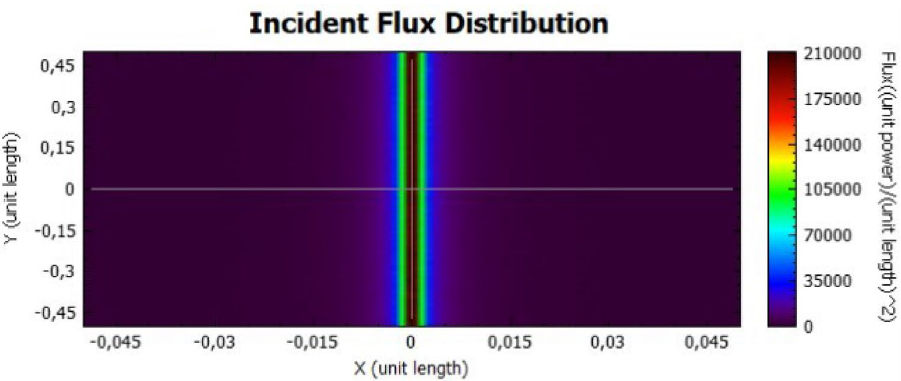
Figure 10. Distribution of incident flux at the receiver from the parabolic concentrator characterised by a reflectivity of 92%.